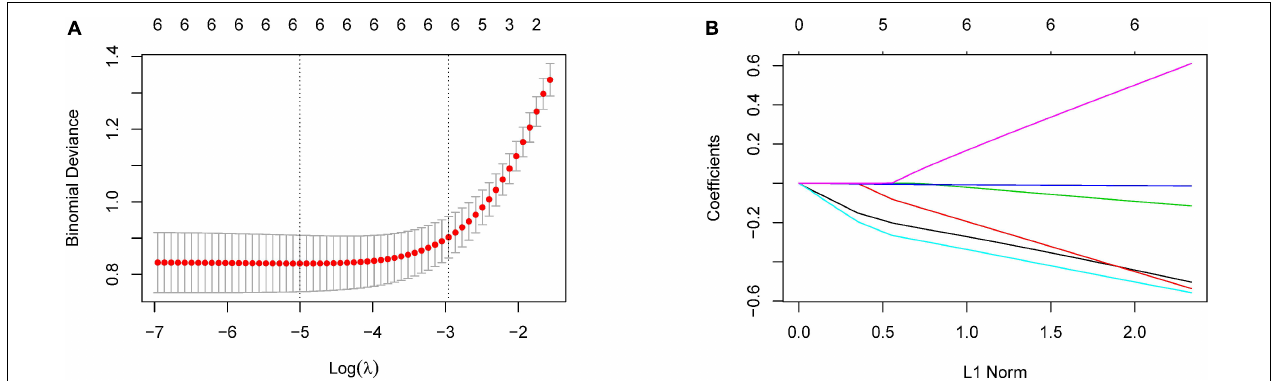
FIGURE 2 | Selection of optimal retinal parameters for modeling by LASSO penalized logistic regression analysis. (A) The optimal set of retinal parameters was selected by tenfold cross-validation and lambda.min. (B) LASSO coefficient profile of retinal parameters.